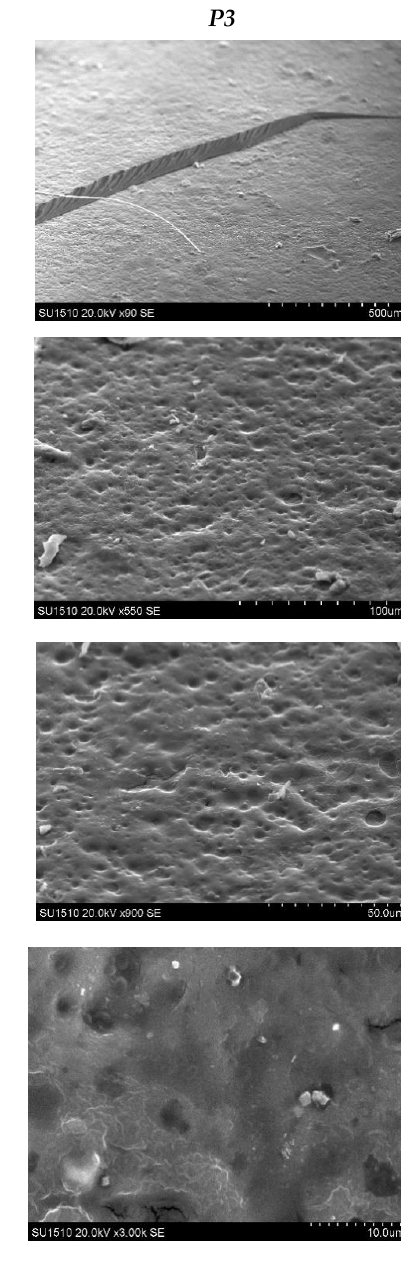
Figure 7. Scanning electron microscopy photographs on the P1 and P3 films surface.